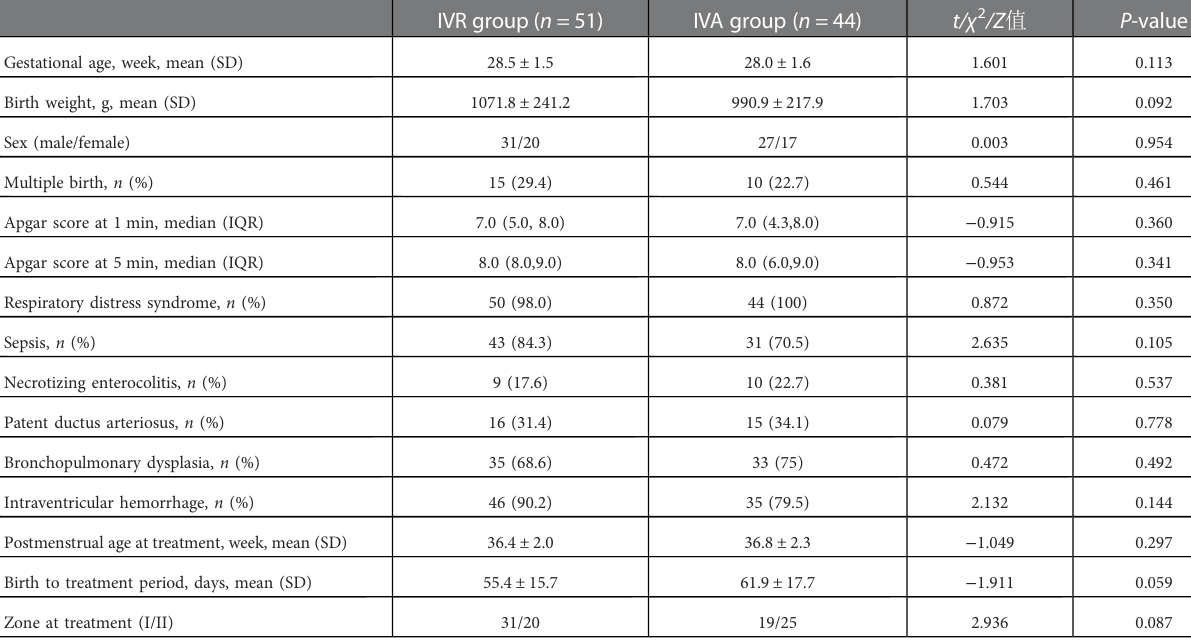
TABLE 1 Comparison of baseline characteristics between the IVR group and IVA group.